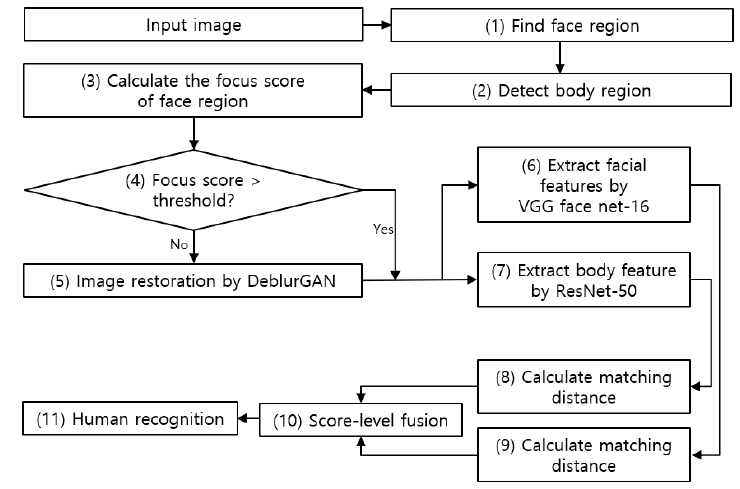
Figure 1. Overall procedure of proposed method.